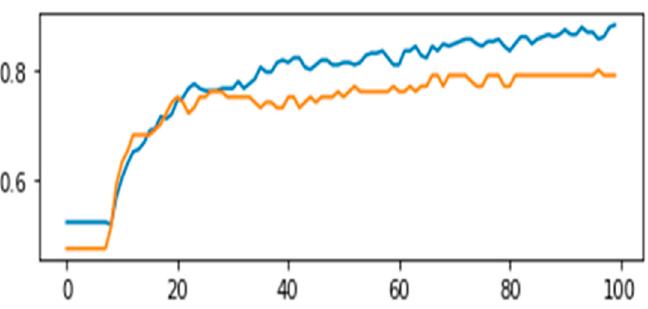
Figure 9. Training and validation accuracy for the emotion and aura modules.